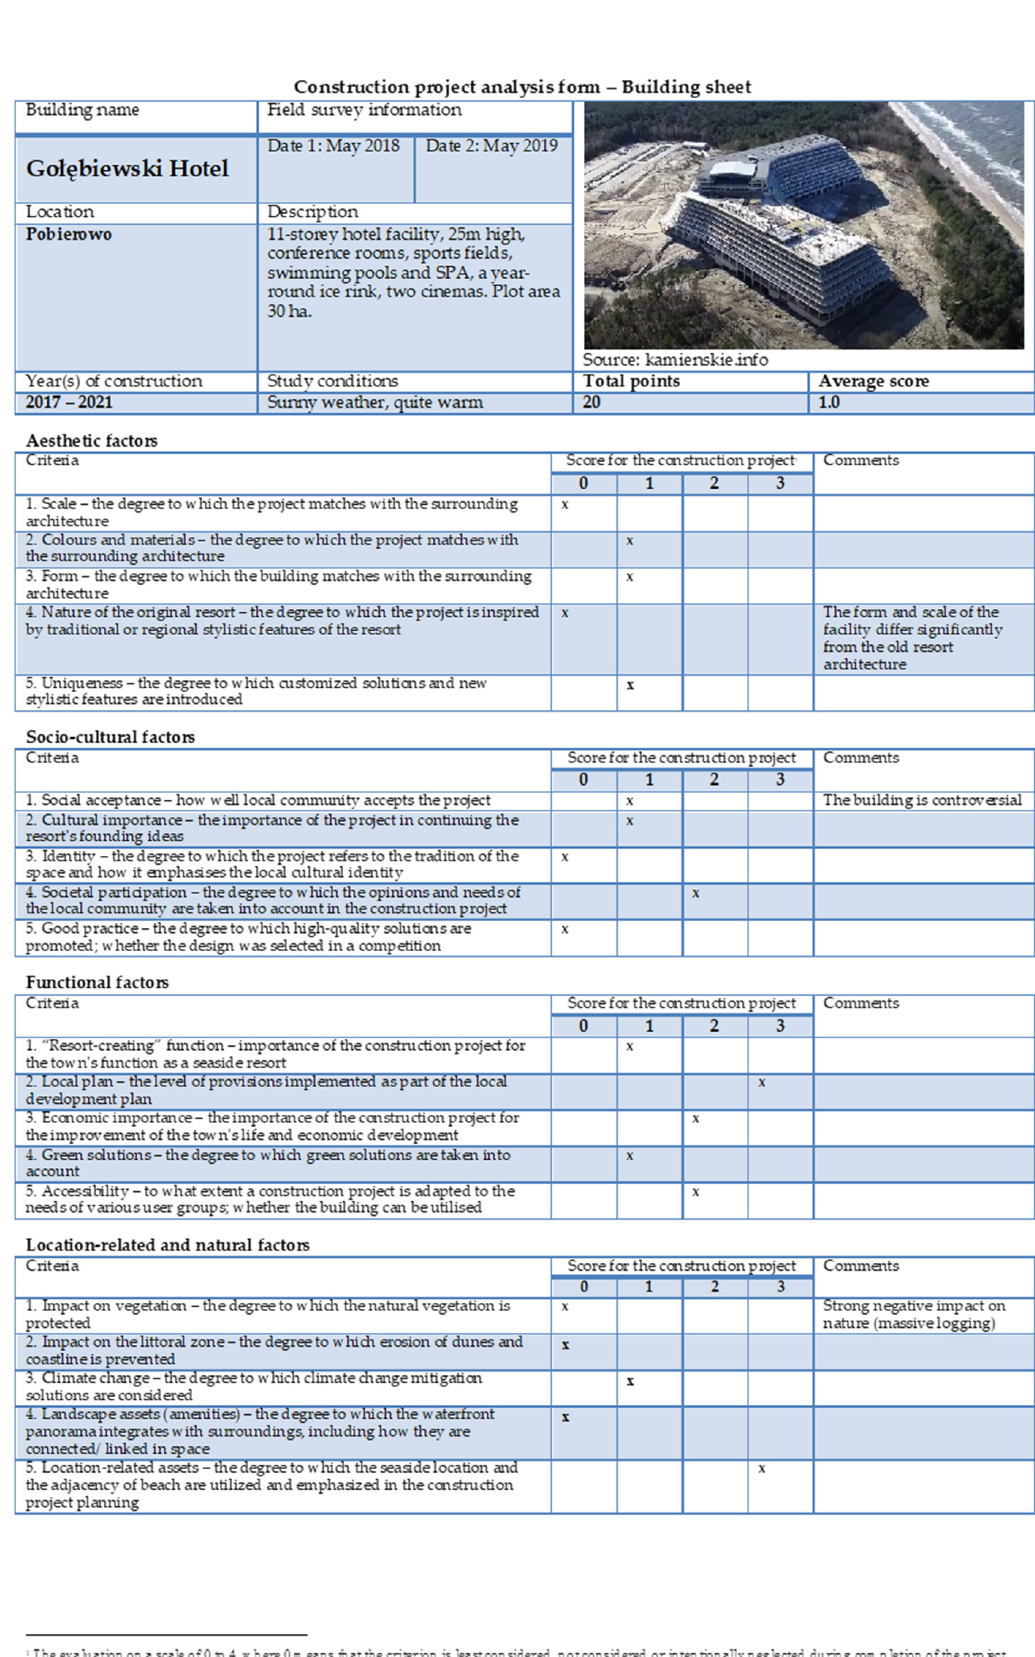
Figure A6. Goł˛ebiewski Hotel in Pobierowo. Building Figure A6 . Go łę biewski Hotel in Pobierowo. Building sheet.